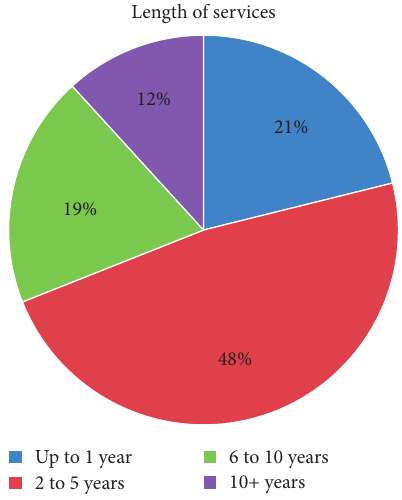
Figure 3: Length of the services of the respondents.